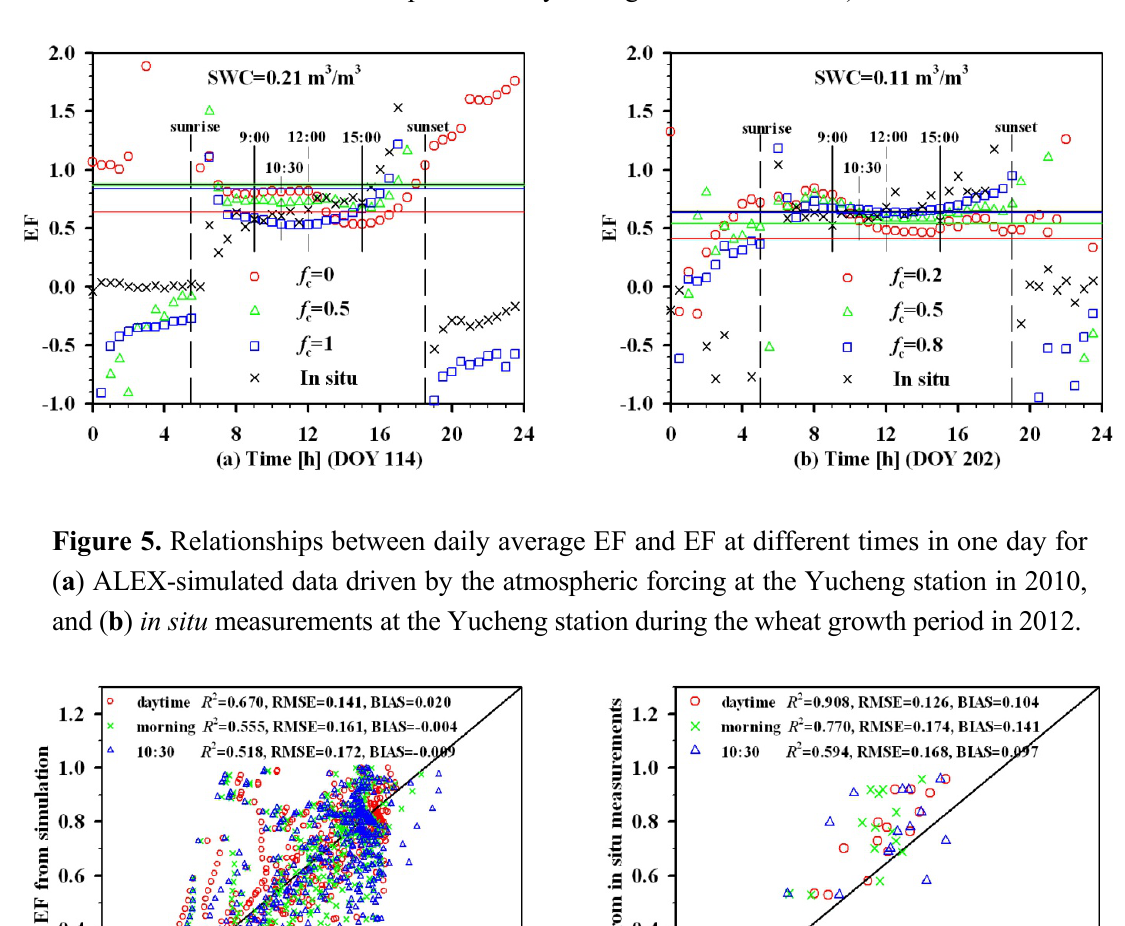
Figure 4. Diurnal cycle of EF driven by atmospheric forcing obtained at the Yucheng station ( a ) on 24 April (DOY114), and ( b ) on 21 July (DOY 202) 2010 (The horizontal lines with different color correspond to daily average EF for each case).